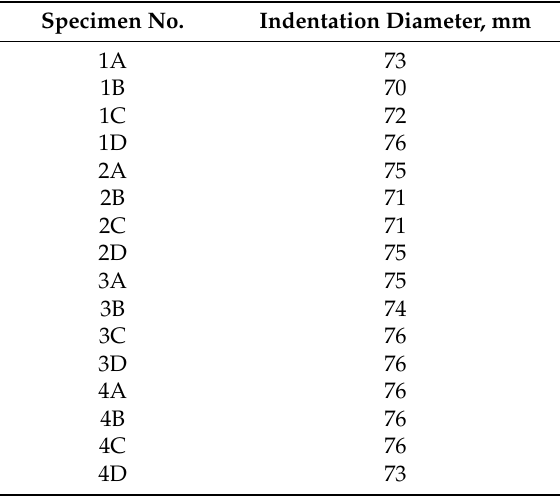
Table 5. Indentation diameters on specimens in ball drop test.